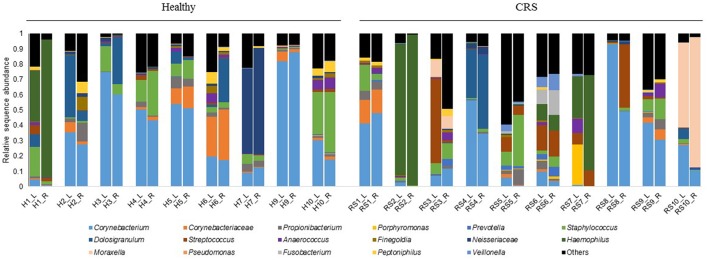
Bacterial community composition of the left (L) and right (R) middle meatus from individuals with CRS and healthy controls. Each color represents a different bacterial genus or family that dominated in the samples. Sequences that do not associate with the dominant genera/families are grouped into “Others.” Relative abundances of 16S rRNA gene sequences are displayed for each sample. L is for left and R is for right middle meatus, H is for healthy controls and RS is for CRS. Patients are labeled 1–10 for the two cohorts, with the exception of patient eight for the healthy cohort, who was not included in this study.